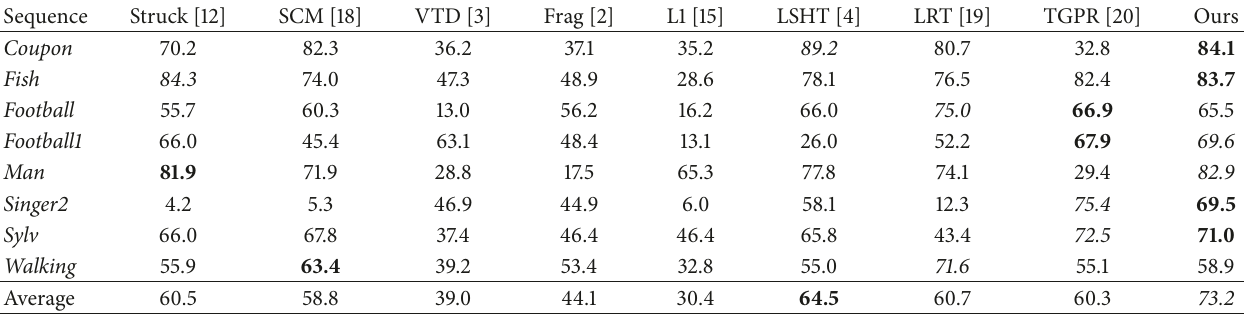
Table 5: Average overlap rates (%). The best two results are shown in italic and bold colors, respectively.